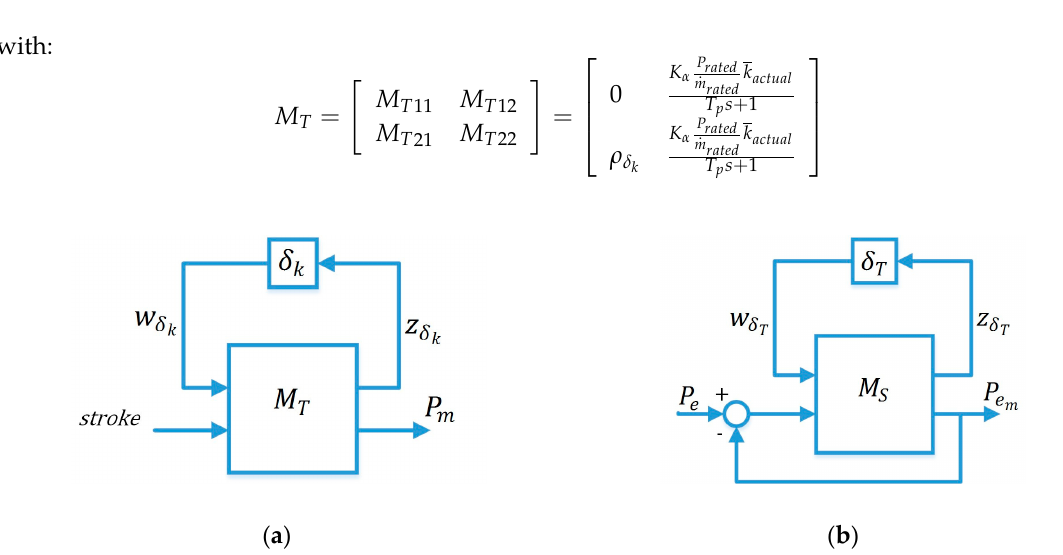
Figure 11. ( a ) Turbine model with uncertainty parameter pulled out; ( b ) Sensor model with uncertainty parameter pulled out.